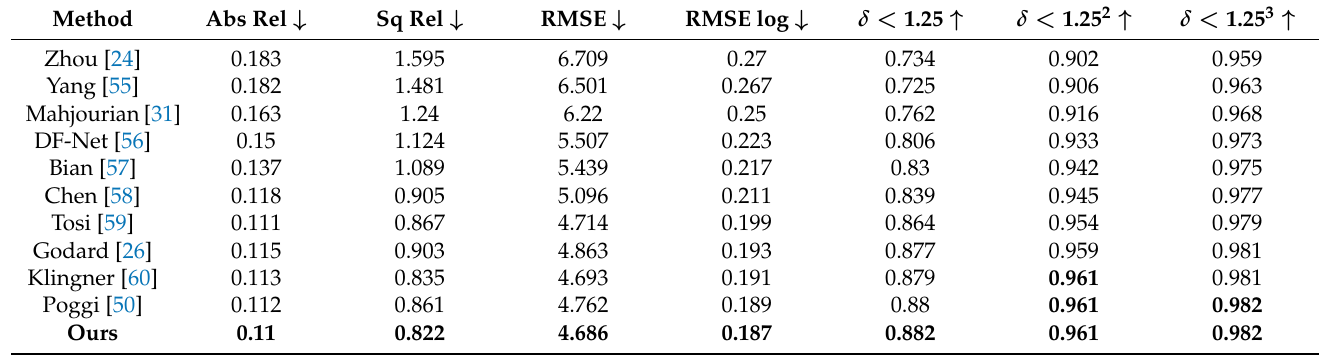
Table 1. Quantitative results. Comparison of our method with existing methods using the Eigen split on KITTI [54]. The best results in each metric are shown in bold.